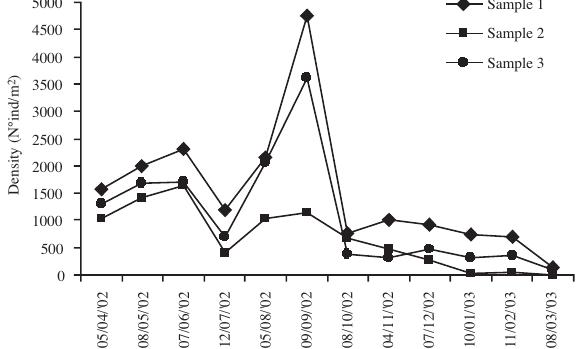
F IG . 2. – Monthly variation in population density (ind/m 2 ) during the sampling period.